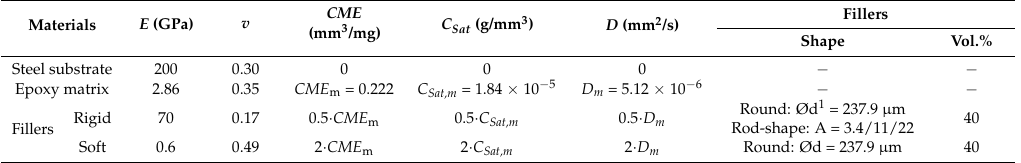
Table 3. Material properties of epoxy, fillers and substrate for hygroscopic stress